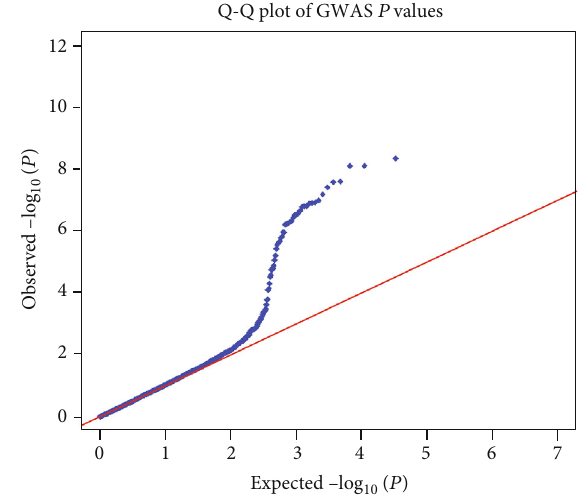
Figure 2: Quantile-quantile (Q-Q) plot of SNPs from ITP GWAS in Chinese Han population. X -axis is the expected value (-log and Y -axis is the actual observed value (-log